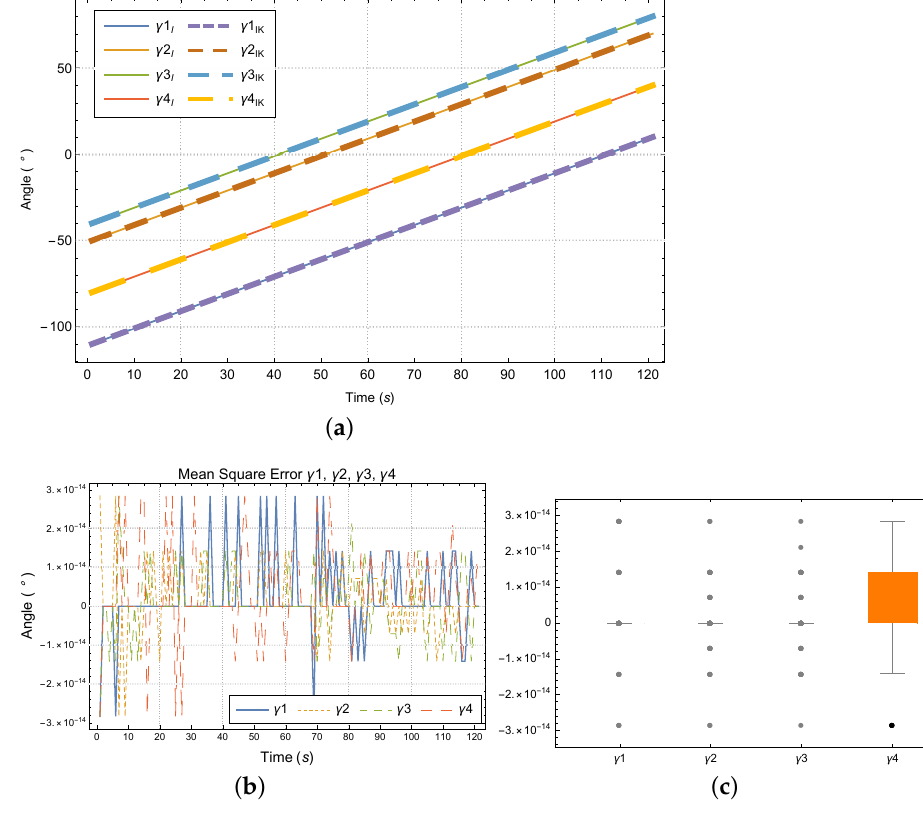
Figure 7. A comparison of the mathematical models of the inverse kinematics. ( a ) Comparison of the inverse kinematics ( γ 1 , γ 2 , γ 3 , γ 4 ) between CAD mechanical design and inverse kinematics equations. ( b ) Mean Square Error of the inverse kinematics. ( c ) Box plot of the inverse